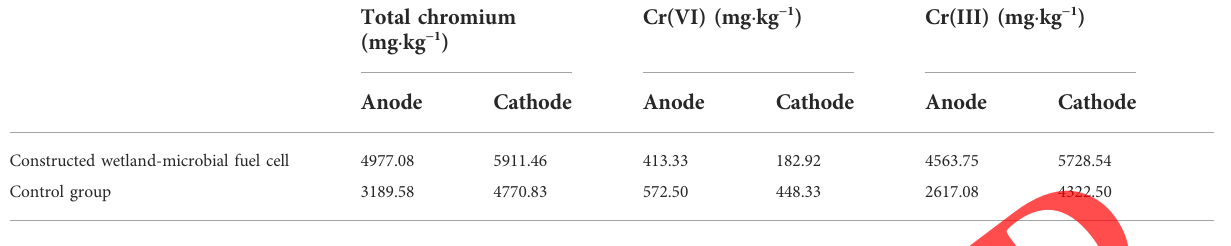
TABLE 3 Bioconcentration and translocation